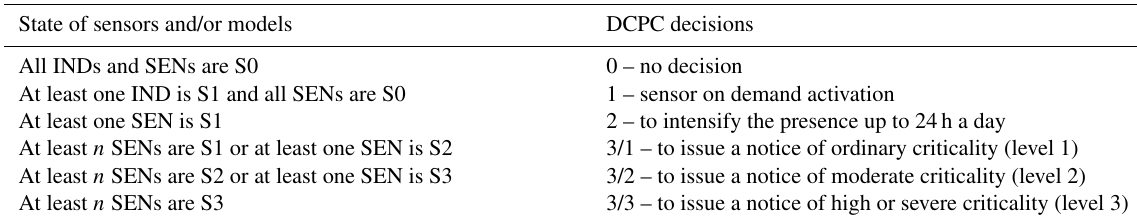
Table 1. DCPC possible decisions. State of sensors and/or models DCPC